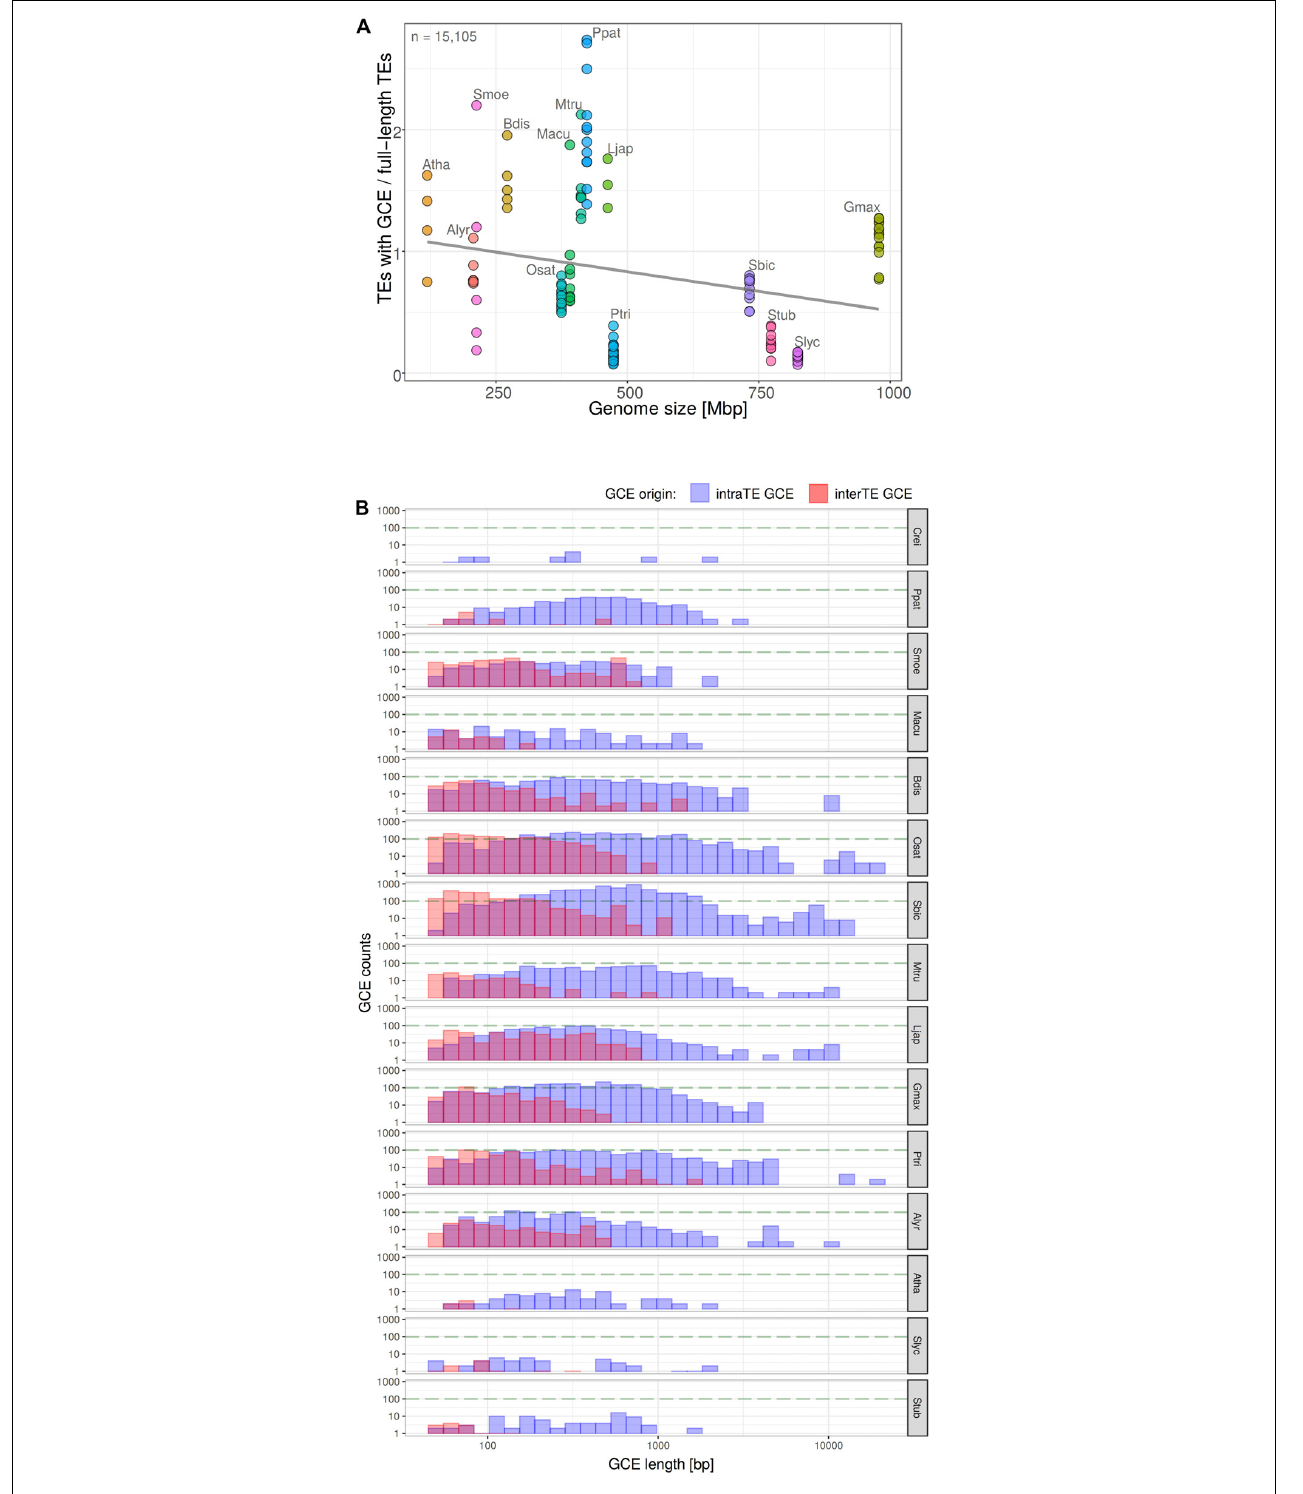
FIGURE 6 | Measurement of gene conversion events (GCE) along the LTR retrotransposons by GENECONV software. Proportion of LTR retrotransposons with GCE plotted against genome size in plant genomes (A) ( y = 1.16 – 0.000644 x ; R 2 = 0.059; Pearson’s r = –0.2420 with p -value = 0.005175). Total count of elements with GCE is indicated. Each filled circle corresponds to one chromosome, plant species are labeled by different colors. The GCE length distribution with respect to the origin of GCE donor LTR i.e., from the same element or from the other one (B) .